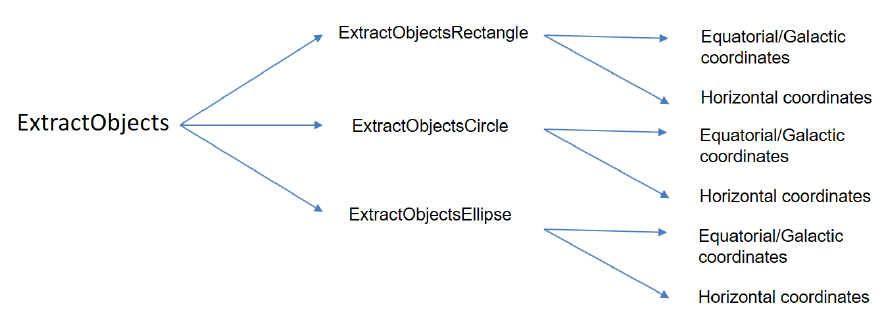
Figure 1: Scheme of the extraction